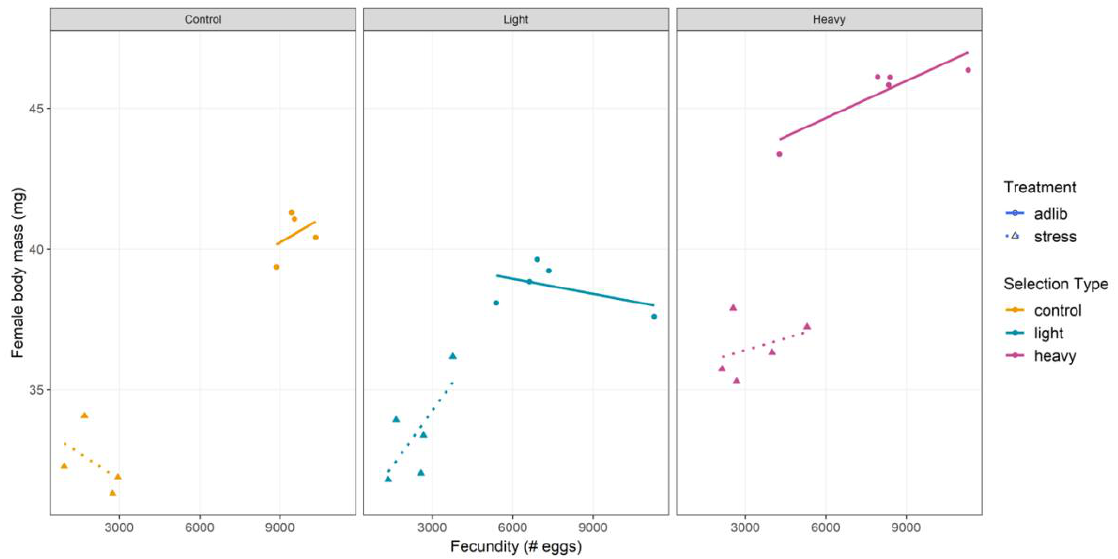
Figure 8: Relationship between reproductive and growth traits of experimental lines of the female body mass selection scheme. Each point refers to a replicate line in a given experimental condition. Dots and triangles indicate lines in ad libitum and stressful conditions, respectively. Solid and dashed lines represent linear regression for ad libitum and stressful conditions, respectively. Color code is similar to Figure